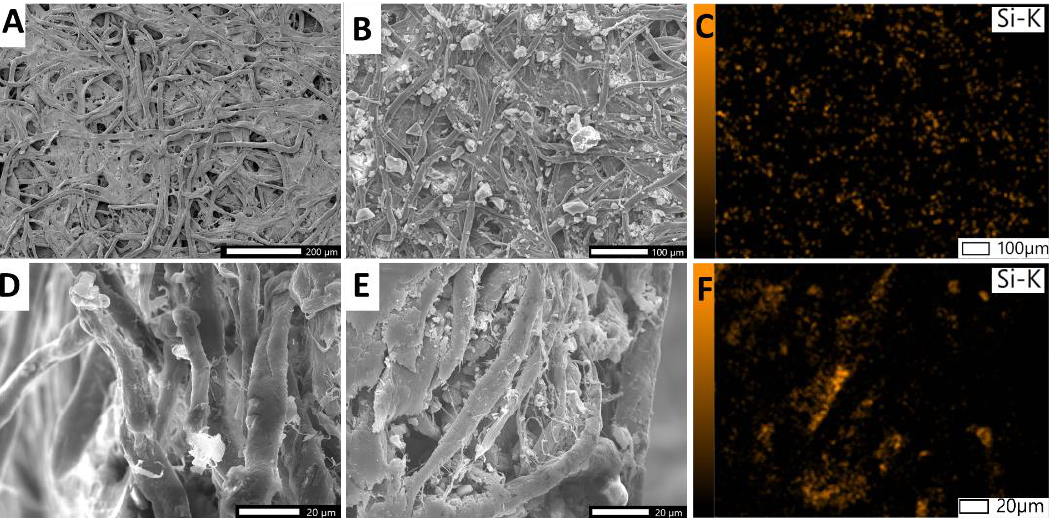
Figure 3. SEM images of filter paper at the detection zone of µPADs. ( A , D ) unmodified paper, top and cross-sectional view respectively. ( B , E ) treated paper, top and cross-sectional view respectively. ( C , F ) EDS images of treated paper, top and cross-sectional view respectively.